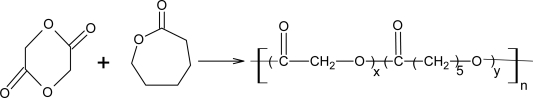
Synthesis of (PGCL) [24].